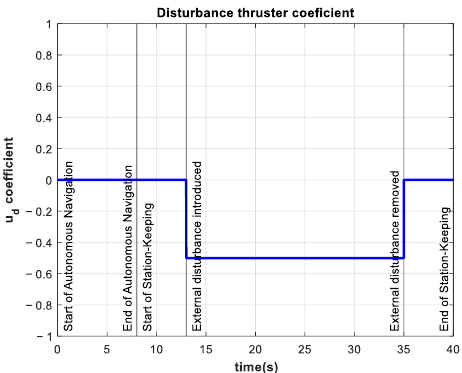
18 of 23 Figure 16. Experimental results for depth station-keeping with an external disturbance of ~20 N introduced in the interval 13 s ≤ 𝑡 ≤ 25 s . Depth ( left ) and tracking error ( right ). As can be seen in Figure 17, the control signal 𝜏 𝑧 and thus the coefficients 𝑢 5 and 𝑢 6 increase their mean value. This is due to the controller requesting more power from the thrusters in order to overcome the unknown external disturbance trying to push the vehicle out of its reference. Figure 17. Experimental results for depth station-keeping with an external disturbance of ~20 N introduced in the interval 13 s ≤ 𝑡 ≤ 25 s . Control signal 𝜏 𝑧 ( left ) and thruster coefficients 𝑢 5 , 𝑢 6 ( right ).